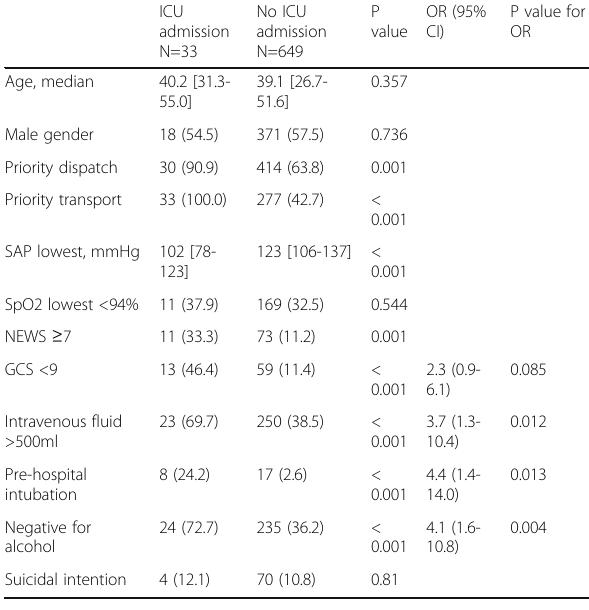
Table 1 (abstract 001410). Factors associated with admission to Intensive Care Unit in 682 poisoning patients transported by EMS to Oulu University Hospital in 2015-2017. Odds ratio values result from logistic regression